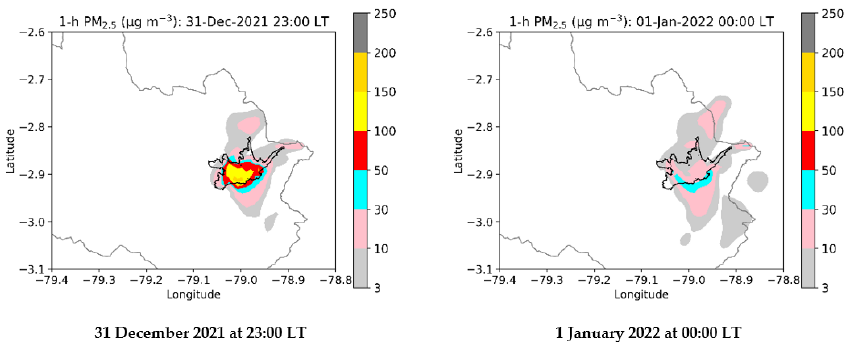
Figure A2. Modeled maps of hourly PM 2.5 concentrations from 31 December 2021 at 19:00 LT to 1 January 2022 at 00:00 LT. Scenario assuming that New Year’s emissions began on 31 December 2021